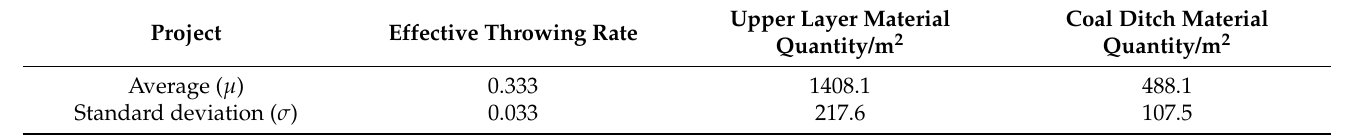
Table 5. Three basic indexes under the condition of 40 m blasting step height.